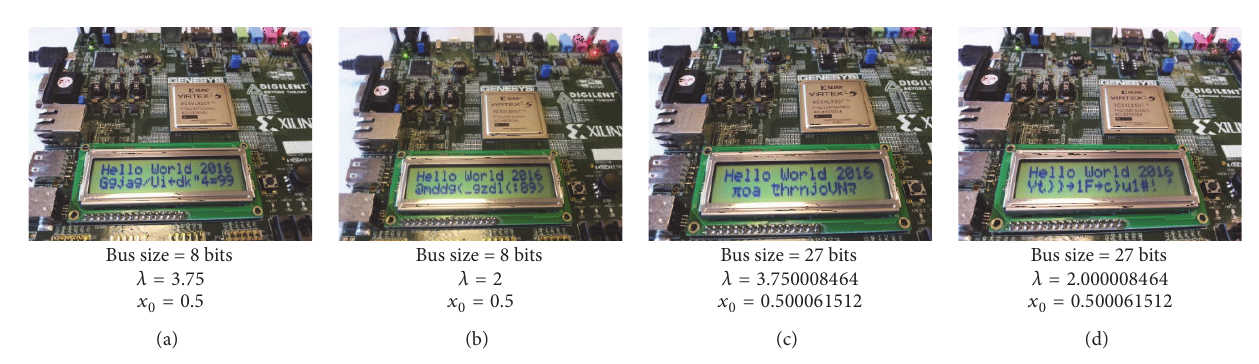
Figure 20: Results of the prototype for different bus sizes and encryption